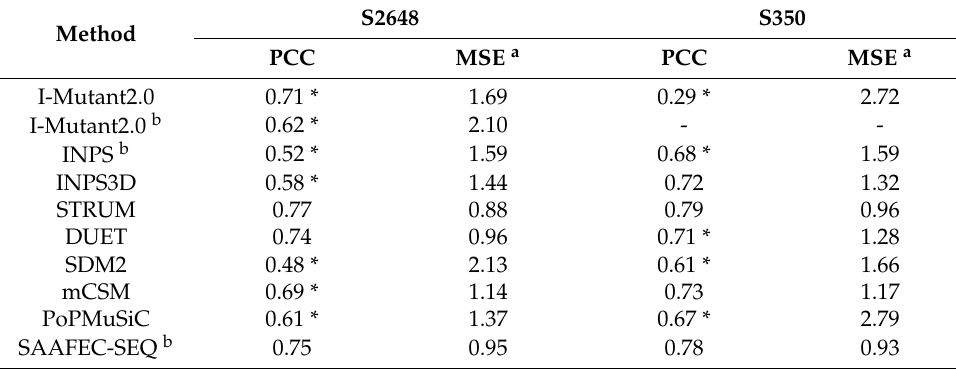
Table 1. Comparison of different methods on the S2648 and S350 datasets.